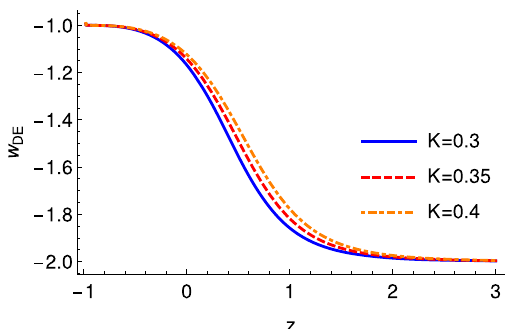
Fig. 2 The evolution of the effective dark energy equation-of-state parameter w DE , for different values of the Kaniadakis entropic param- eter K in units of k B , in the case of (cid:2) = 0. In all cases we have obtained density parameters evolution similar to the graphs of Fig. 1, and (cid:4) m 0 lies inside the 2 σ region according to Planck Collaboration, namely (cid:4) ≈ 0 . 31 ± 0 . 014 m 0